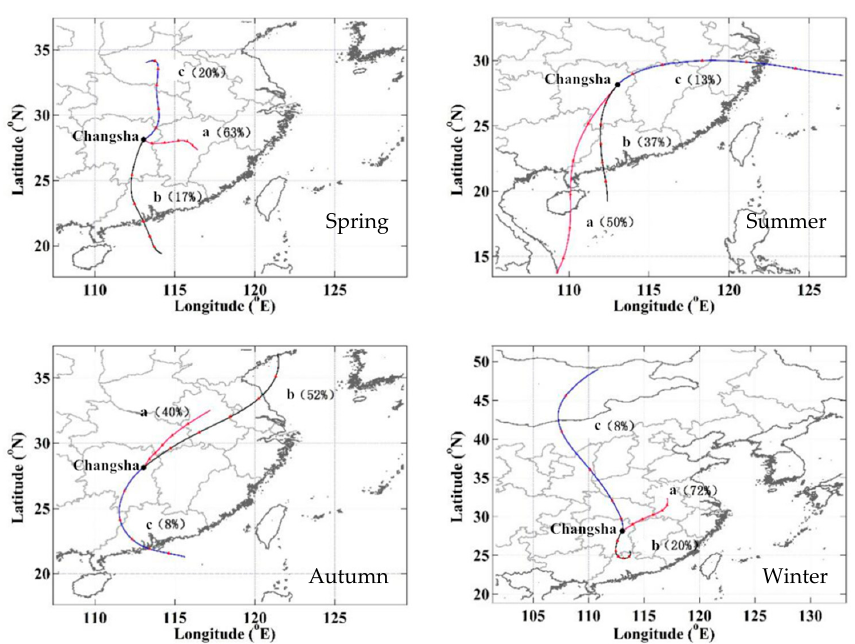
Figure 9. Airflow trajectory clustering in different seasons.